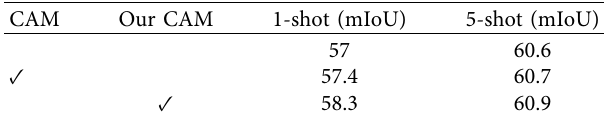
Table 3: The ablation study on the PASCAL-5 i dataset and ResNet 50